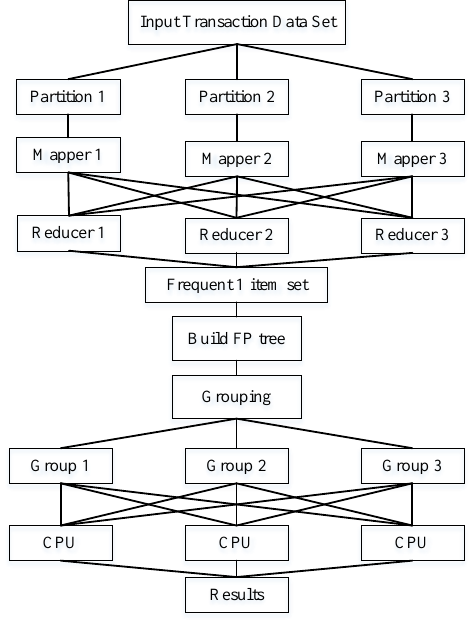
Figure 7. Find hypothetical computing frameworks in